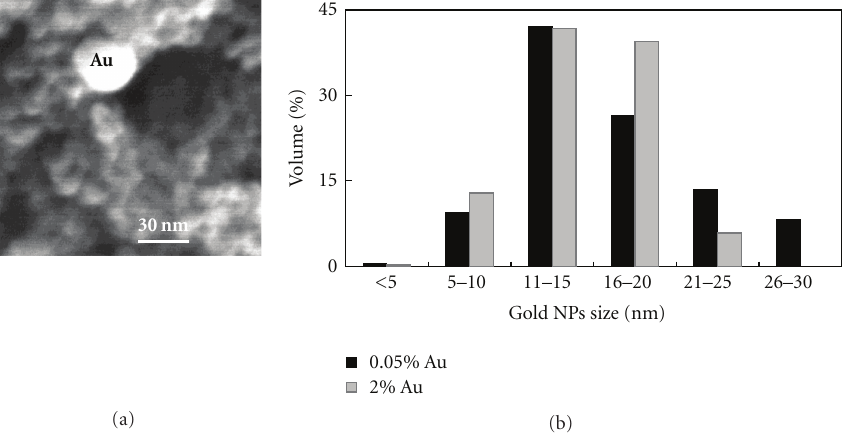
Figure 9: STEM image of Au/TiO 2 : ST-01 (0.05wt% Au) and comparison of distribution of gold NPs sizes for two amounts (0.05 and 2wt%) of deposited gold on anatase ST-01